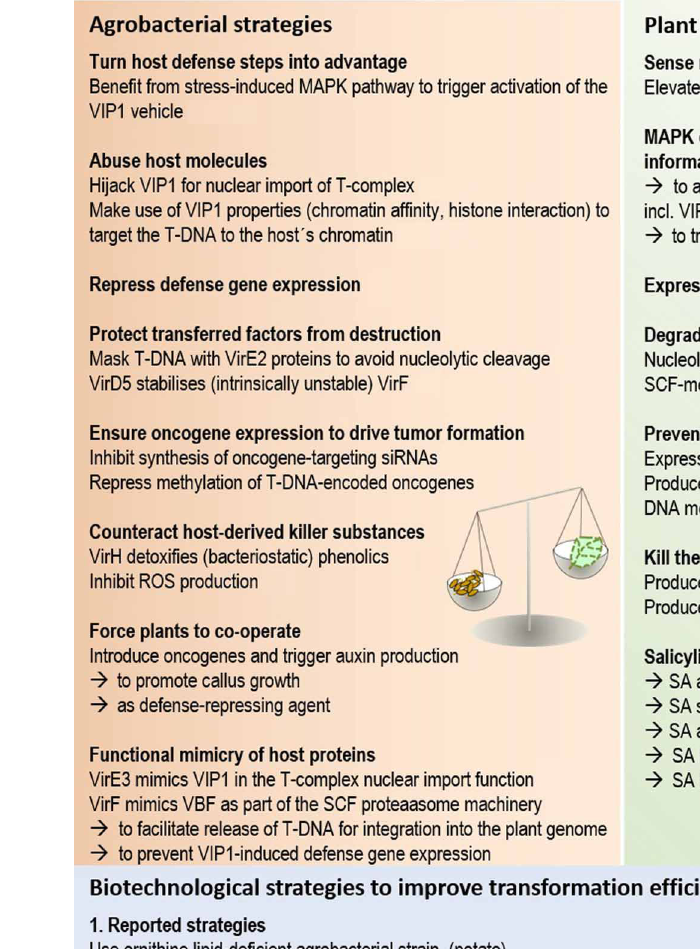
Frontiers in Plant Science | Plant-Microbe